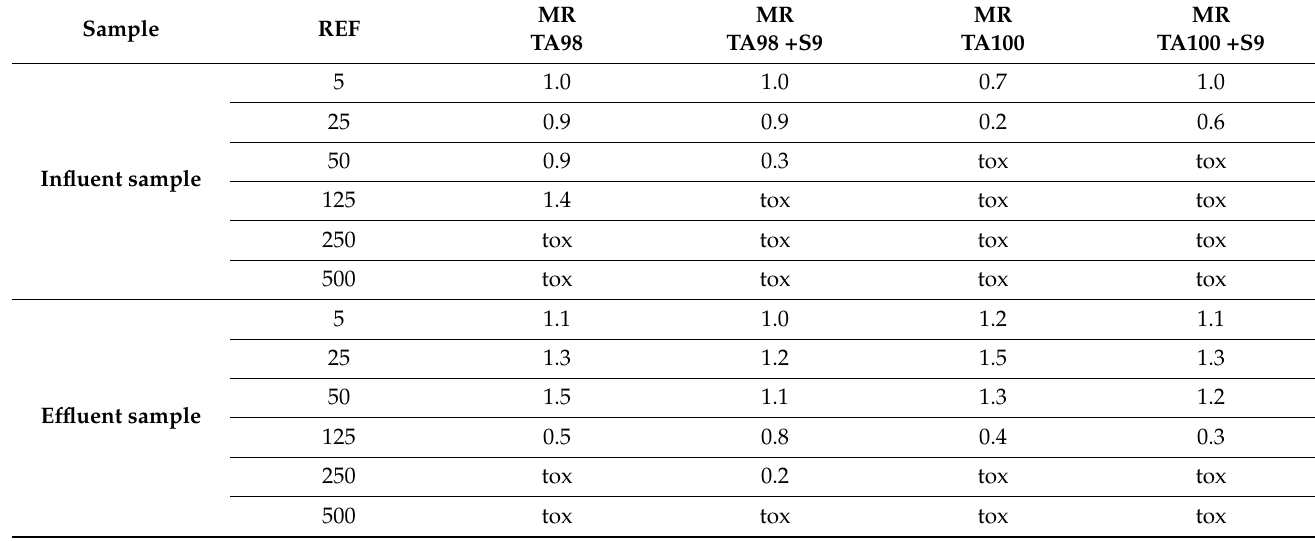
Table 6. Results of Ames test on Salmonella typhimurium (TA98 and TA100 strain ± S9) expressed as mutagenicity ratio (MR) and REF values.